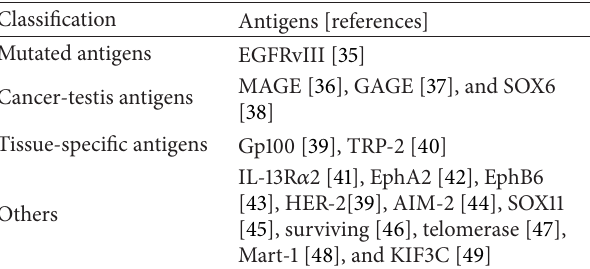
Table 1: Glioma-associated